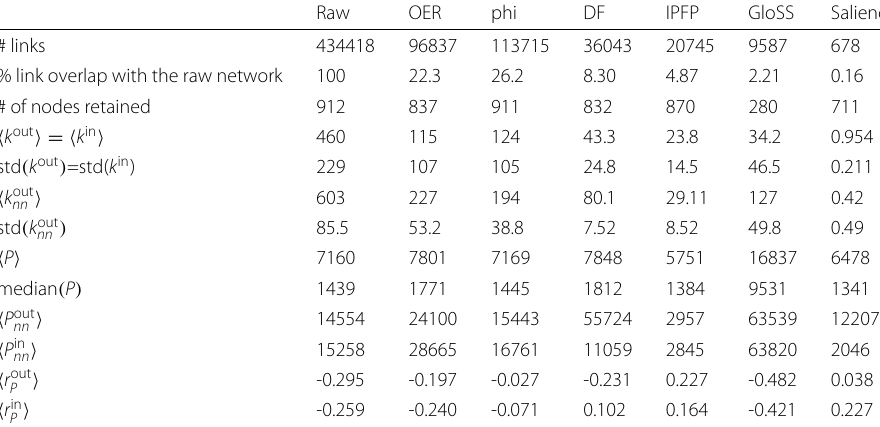
Table 3 Summary statistics of the constructed networks